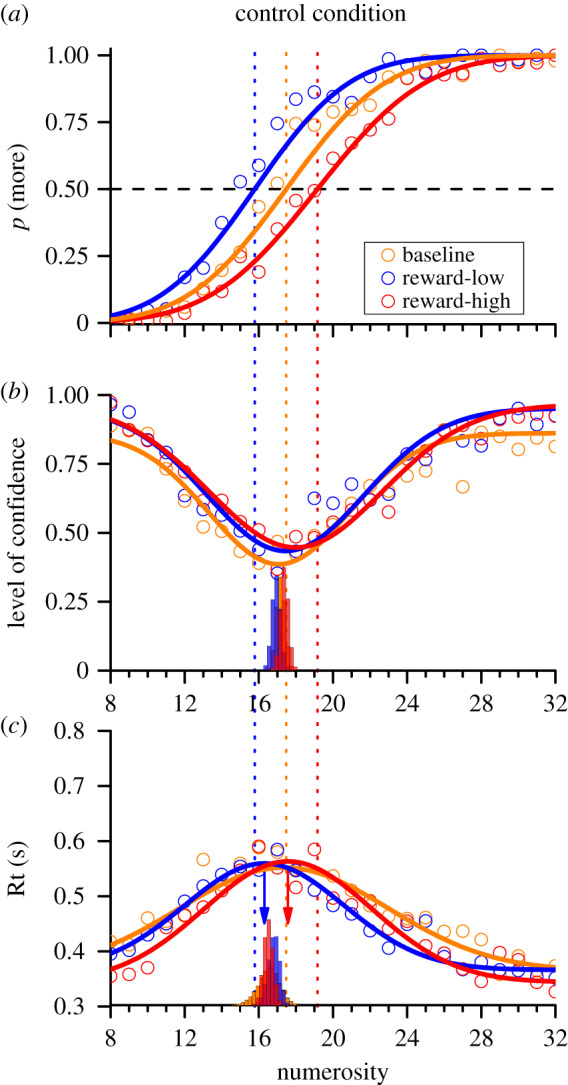
(a) Psychophysical functions of proportion of trials when the test was seen as more numerous than the neutral probe, as a function of physical numerosity in the control condition (baseline in orange, leftward condition in blue and rightward condition in red). (b) Expressions of confidence, as a function of physical numerosity. (c) Mean reaction times (Rt; in seconds) as a function of physical numerosity. The continuous dotted lines indicate the PSE of the psychophysical curves. The histograms below the confidence and reaction time fits represent the bootstrap analysis. (Online version in colour.)